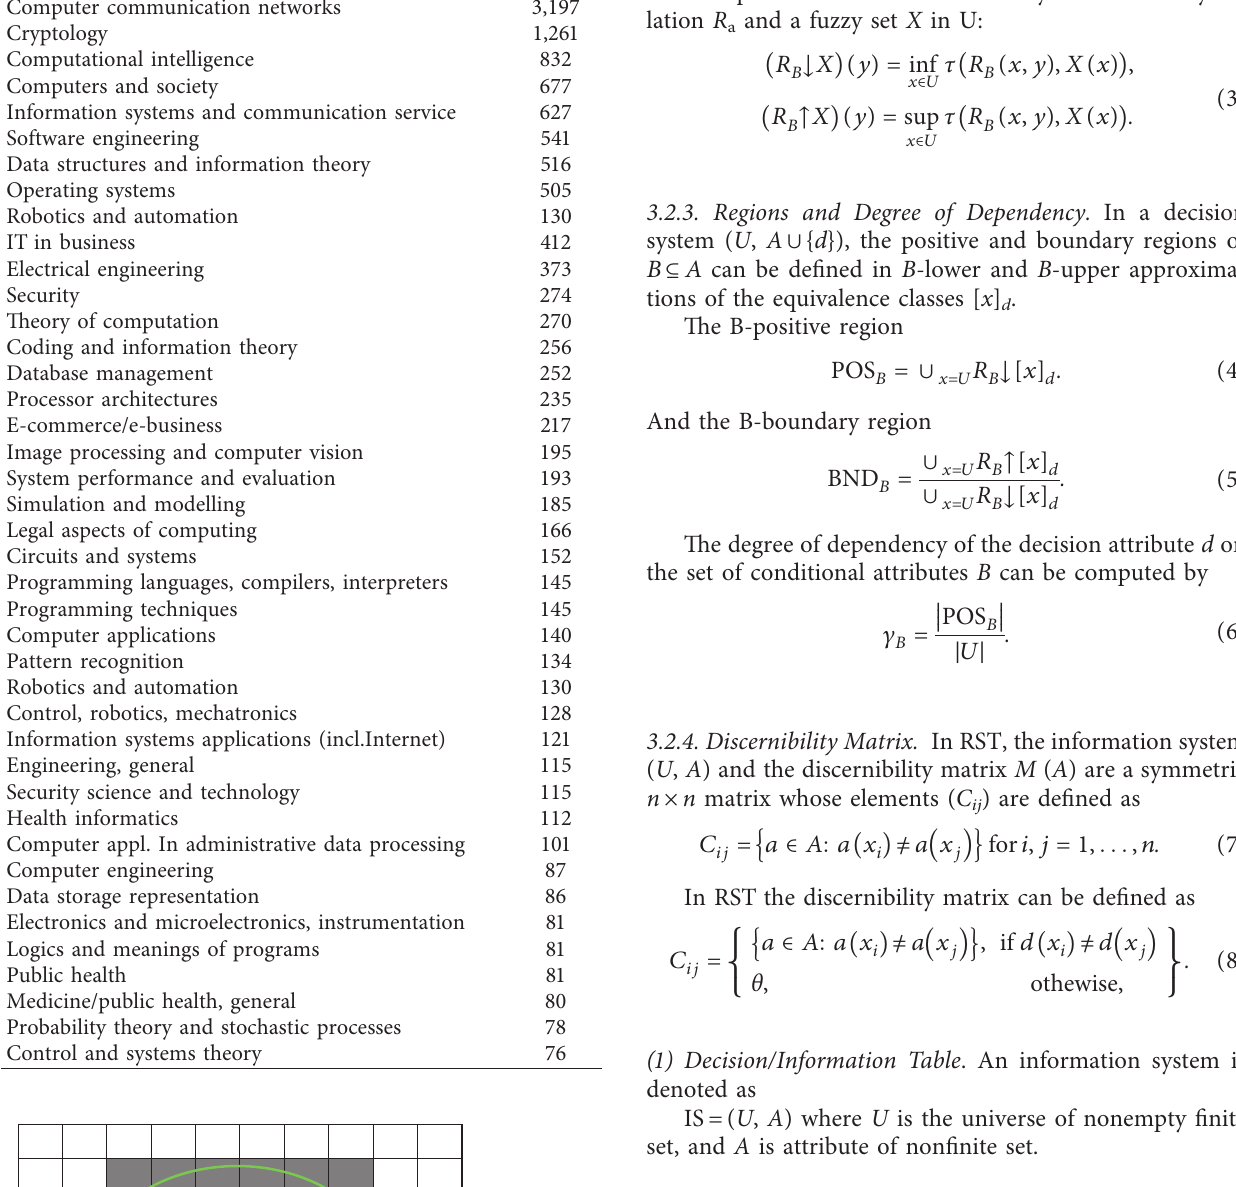
Table 1: Subdiscipline of publications. Subdiscipline Total no.